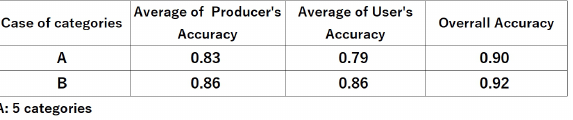
Table 1. Evaluation of classification accuracy